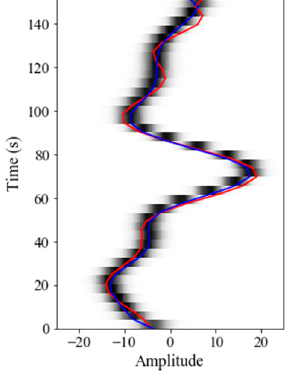
Figure 9. The results of wavelet extraction. Blue line is the MAP solution of wavelet extraction and red line is one wavelet realization drawn by Gibbs sampling. The gray–black color represents the posterior probability density.